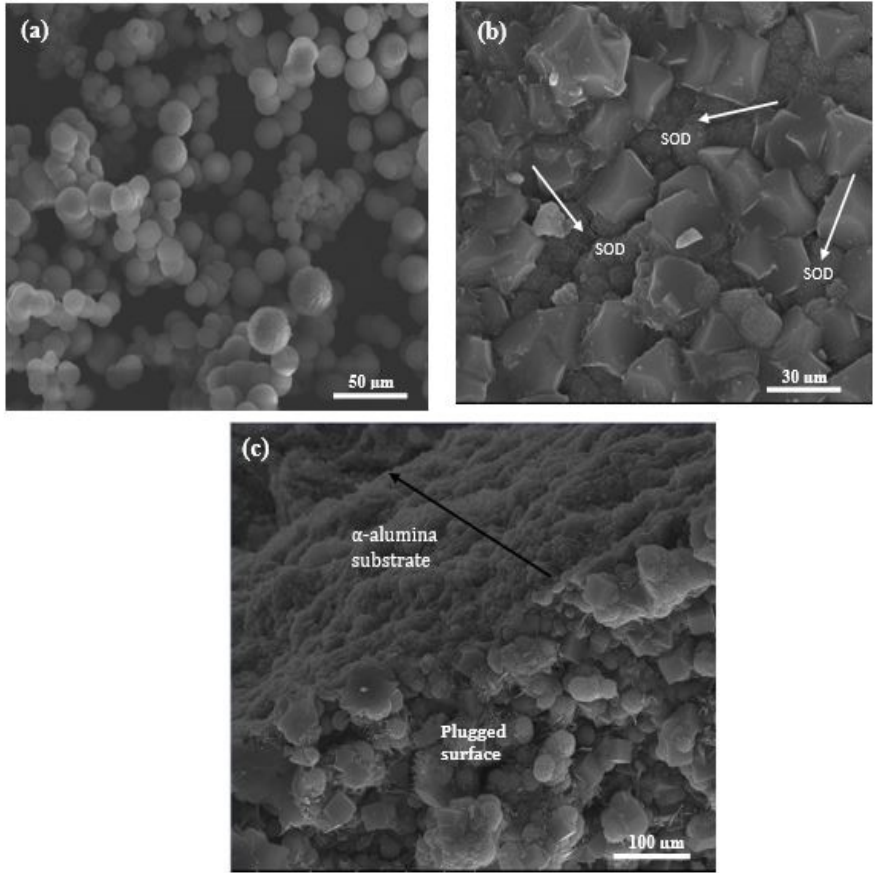
Figure 5. SEM micrographs of ( a ) SOD crystals collected from the bottom of the autoclave, ( b ) membrane surface, and ( c ) membrane cross-section prepared via the pore-plugging hydrothermal synthesis method.